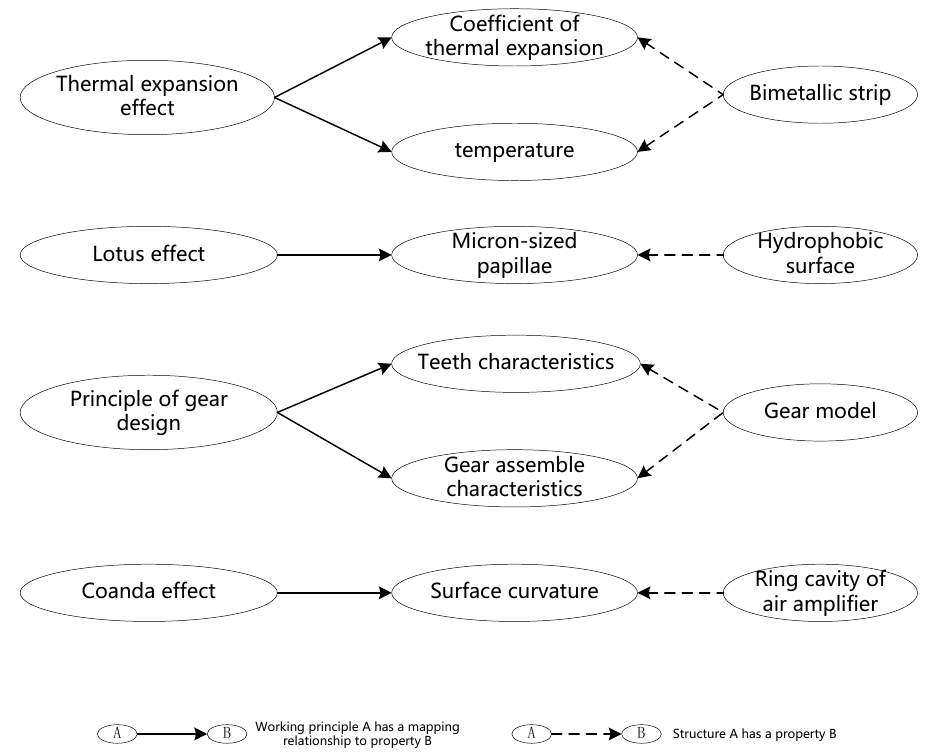
Figure 4. Several mapping examples between the working principle and the property.